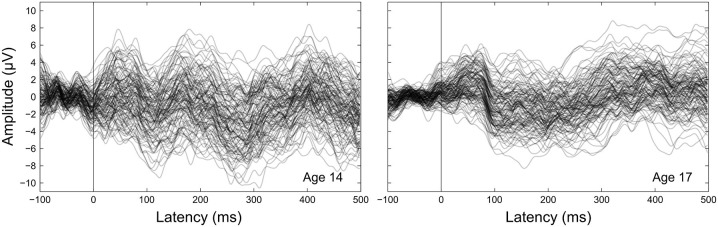
Within-participant CAEP variability. Panels show subaverages from 25 iterations of the bootstrapping procedure used to calculate CAEP variability from the same individual at age 14 (left) and age 17 (right). Each iteration randomly divides a fixed population of 150 artifact-free epochs into five 30-epoch subaverages, across which the CAEP variability metrics are calculated. Final CAEP variability measures are the averaged results of 1000 iterations of this procedure. Subaverages are plotted with partial transparency to visualize within-participant variability, with darker plot regions indicating lower variability.